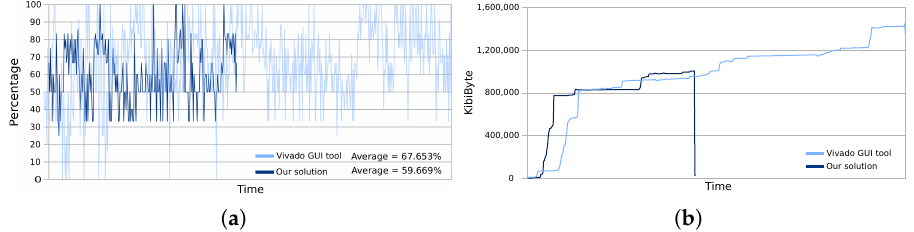
Figure 9. CPU and Memory usage to obtain the bitstream of dfadd kernel. ( a ) consumption-power; ( b )